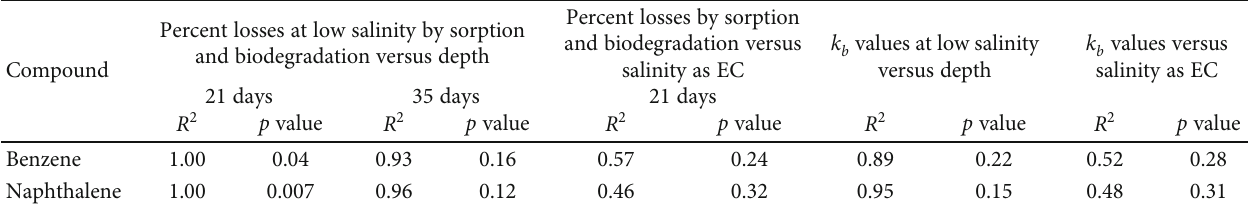
Table 4: Separate statistical regression analyses of the results of biodegradation kinetics as a function of depth and salinity as EC. Percent losses at low salinity by Compound